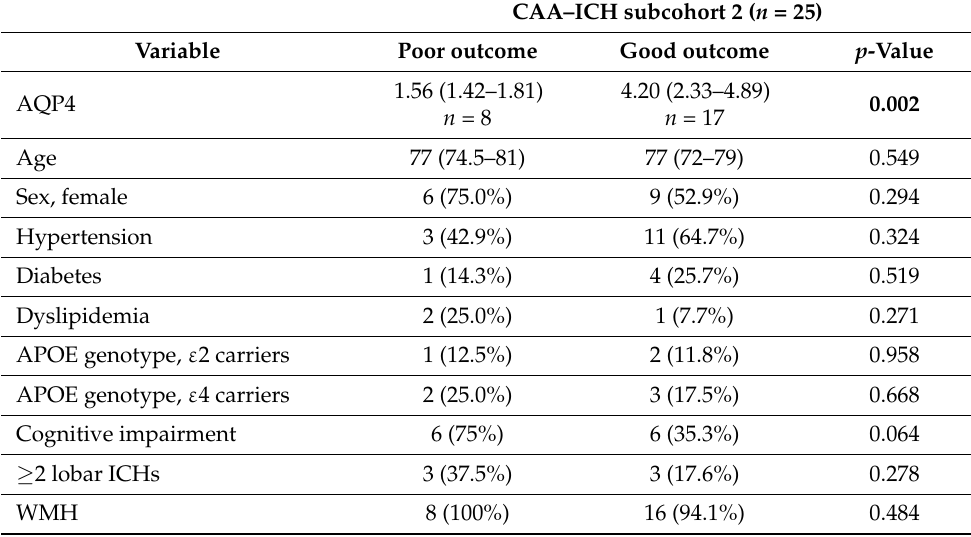
Table A2. Univariate analysis for long-term functional outcome in subcohort